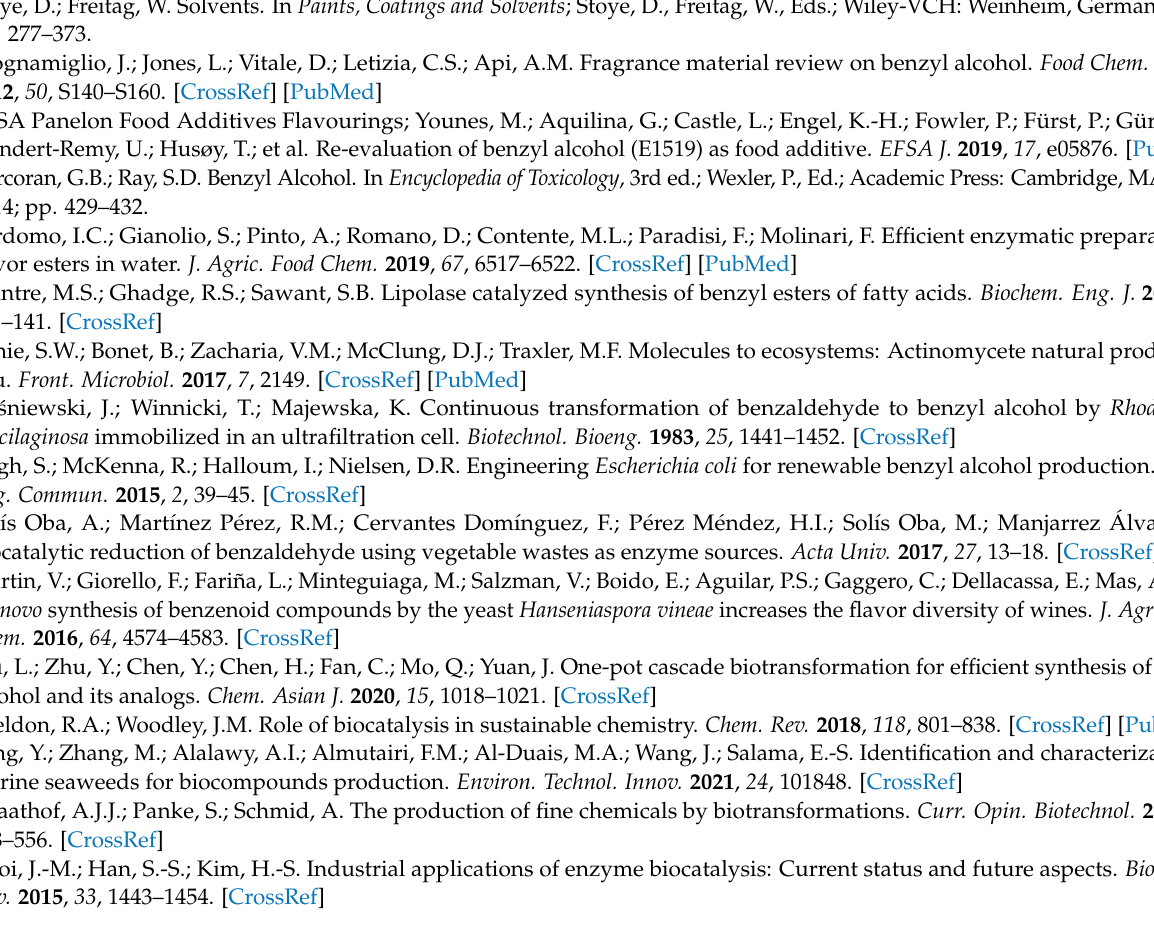
Figure S3: Continuous plug flow reactor (CPFR) setup for the conversion of benzaldehyde to benzyl alcohol; Figure S4: TIC chromatograms obtained by GC-MS of the acetyl acetate used to extract substrate and product; Figure S5: Relative conversion at sequentially cycles of 1 h conducted in 10 mL Verex TM Headspace